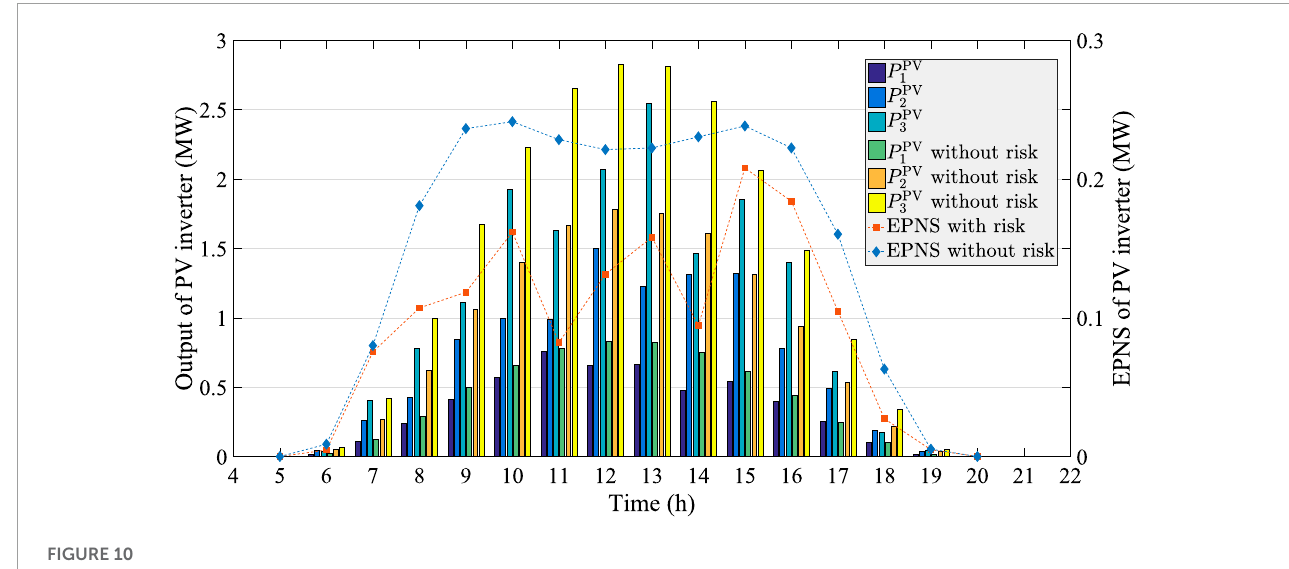
FIGURE 10 The hourly output and EPNS of PV inverter with and without uncertain evaluation.